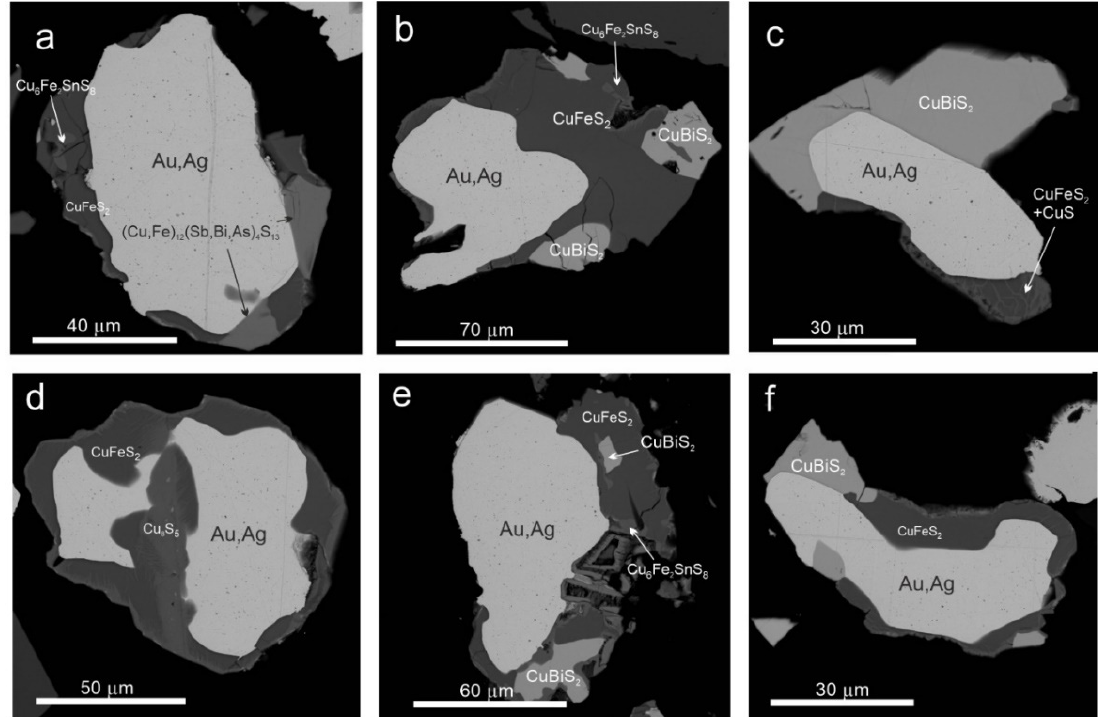
Figure 9. Au-Ag solid solutions from the gold-sulfosalt-quartz association, sample Bar-5-2, Northern zone in intergrowth with chalcopyrite CuFeS 2 , sometimes partially replaced by covellite CuS ( c ) or geerite Cu 8 S 5 ( d ), mawsonite Cu 6 Fe 2 SnS 8 ( a , b , e ), emplectite CuBiS 2 ( b , c , e , f ), and bismuth-rich tetrahedrite Cu 12 (Sb,Bi,As) 4 S 13 ( a ).